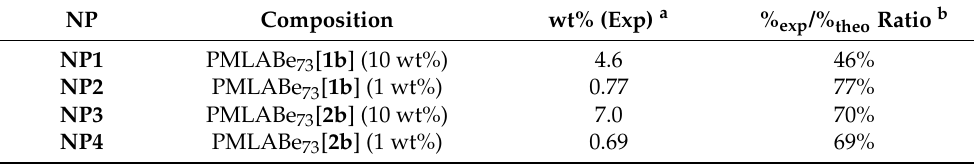
Table 4. Experimental vs. theoretical loadings in porphyrin for NPs.